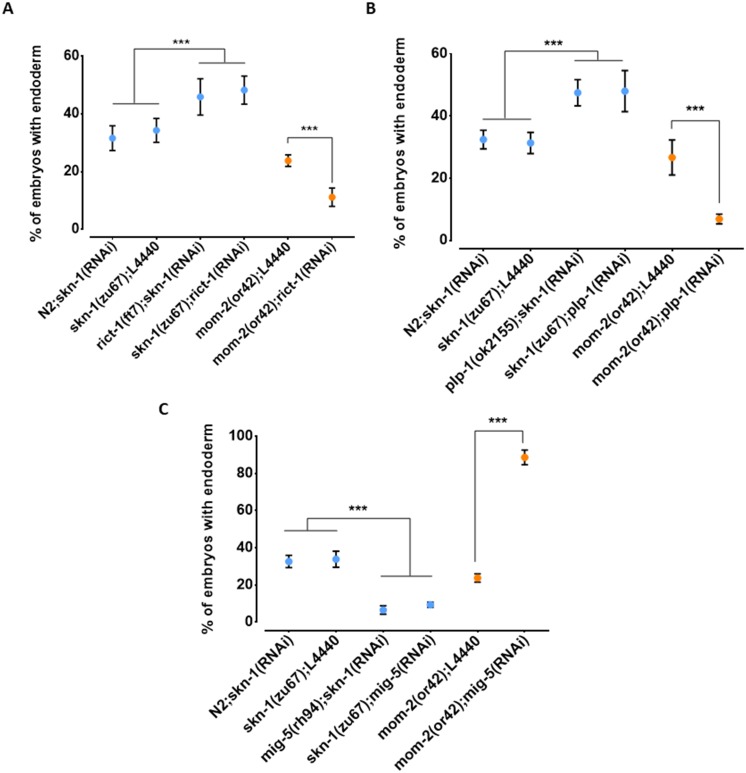
Reciprocal effects of RICT-1, PLP-1, and MIG-5 on skn-1(-) and mom-2(-) phenotypes.(A, B) Loss of RICT-1 or PLP-1 enhances the mom-2(or42) loss-of-endoderm phenotype and suppresses skn-1(zu67) and skn-1(RNAi) phenotype. (C) Loss of MIG-5 enhances the skn-1(zu67) and skn-1(RNAi) phenotype and suppresses mom-2(or42) phenotype. At least three replicates were performed per experiment and >200 embryos per experiment. Student t-test (*** p-value<0.001). Error bars represent standard deviations.